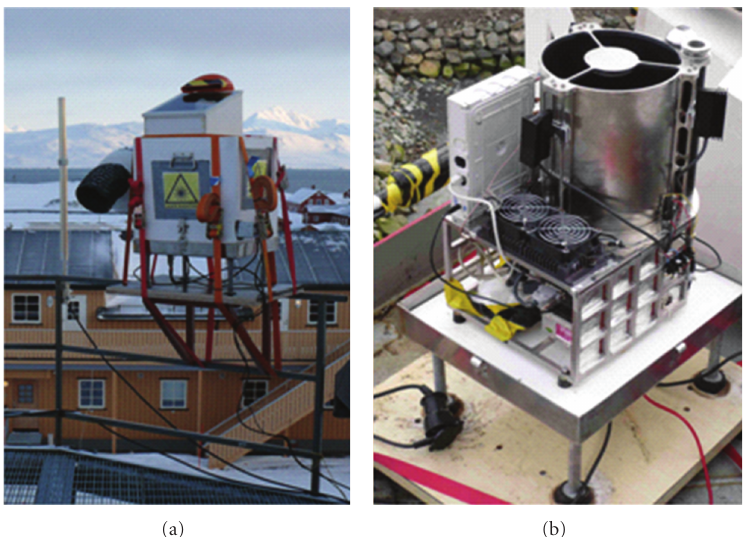
Figure 1: In (a) the micro-lidar (MULID) on the roof of the AWI station at Ny ˚Alesund (78.9 ◦ N, 11.978.9 ◦ N, 11.9 ◦ E), Svalbard. In (b) the optical and electronic components of the